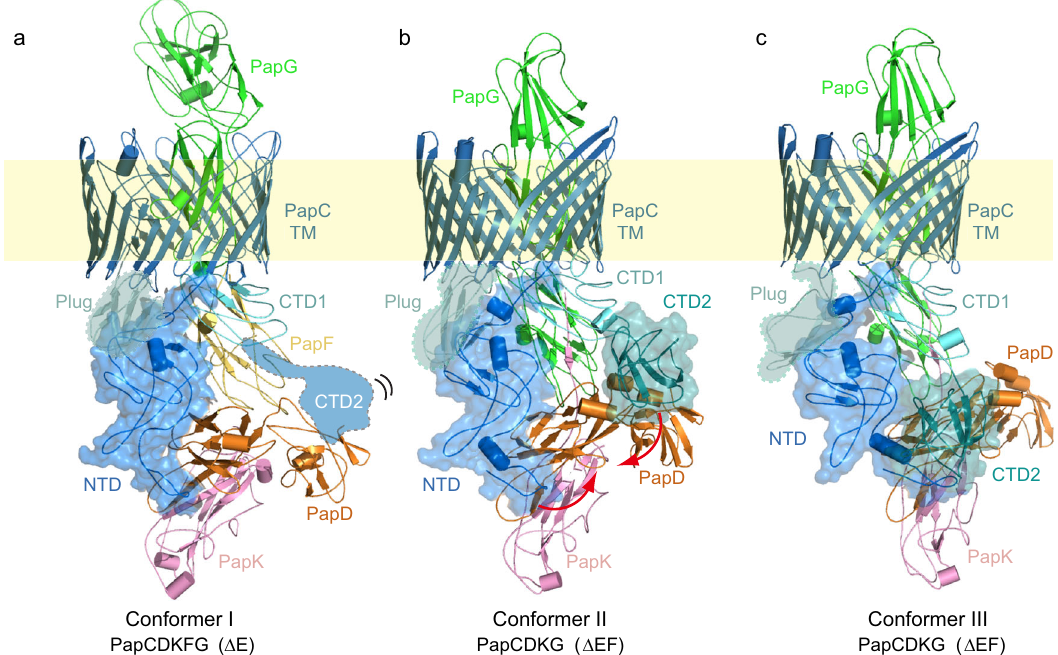
Fig. 2 Atomic models of the Δ E and Δ EF complexes in three distinct con fi gurations. a Atomic model of Δ E Conformer I. b, c Atomic models of Δ EF Conformer II and Conformer III. The NTD and β -barrel of PapC are colored in blue; PapC plug domain in aquamarine; PapC CTD1 and CTD2 in light-teal and teal, respectively; PapD in orange; PapK in pink; PapF in yellow; and PapG in green. The fl exible and invisible PapC CTD2 is highlighted in cartoon view in ( a ). The plug domain is highlighted in teal and surface views of the NTD and CTD2 are shown ( a – c ). TM,